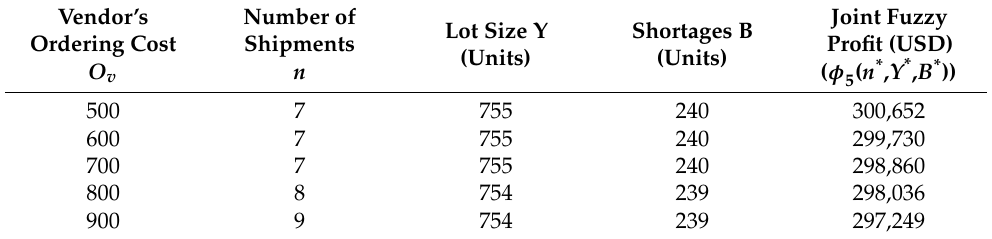
Table 17. Impact of the vendor’s ordering cost on the decision variables and joint fuzzy profit.